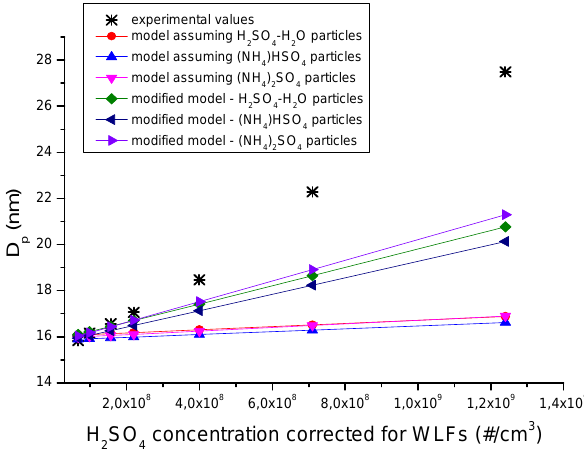
Figure 9. The comparison of the experimental median particle di- ameters from a measurement conducted at T = 283K, with an RH of ∼ 30% and a residence time of 60s, and the values predicted theoretically from a model using the initial H 2 SO 4 concentration without a correction for wall